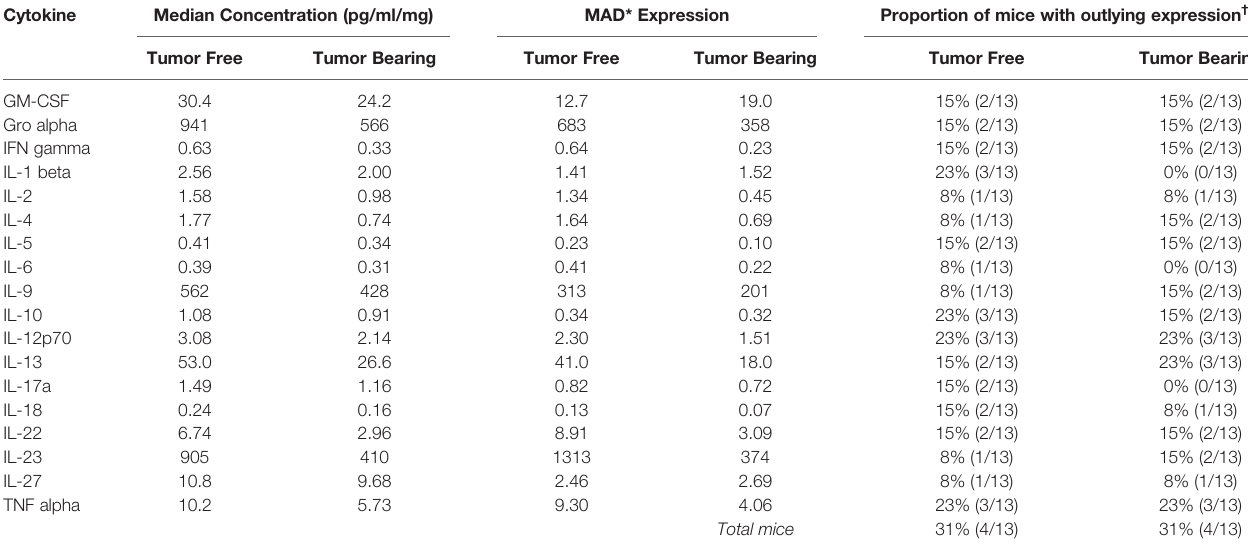
TABLE 6 | Intra-group variability in secretion of cytokines involved in Th1, Th2, Th9, and Th17 signaling from initiated colon tissue from tumor-free and tumor-bearing Apc +/Min-FCCC mice. Cytokine Median Concentration (pg/ml/mg) MAD* Expression Proportion of mice with outlying expression † Tumor Free Tumor Bearing Tumor Free Tumor Bearing Tumor Free Tumor